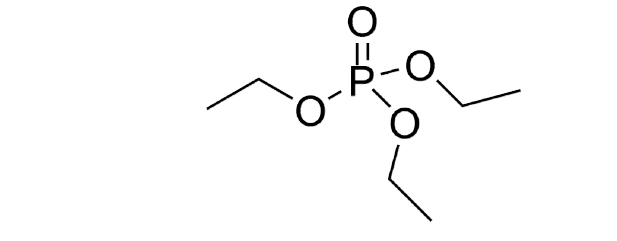
Figure 1. Molecular structure of TEP.